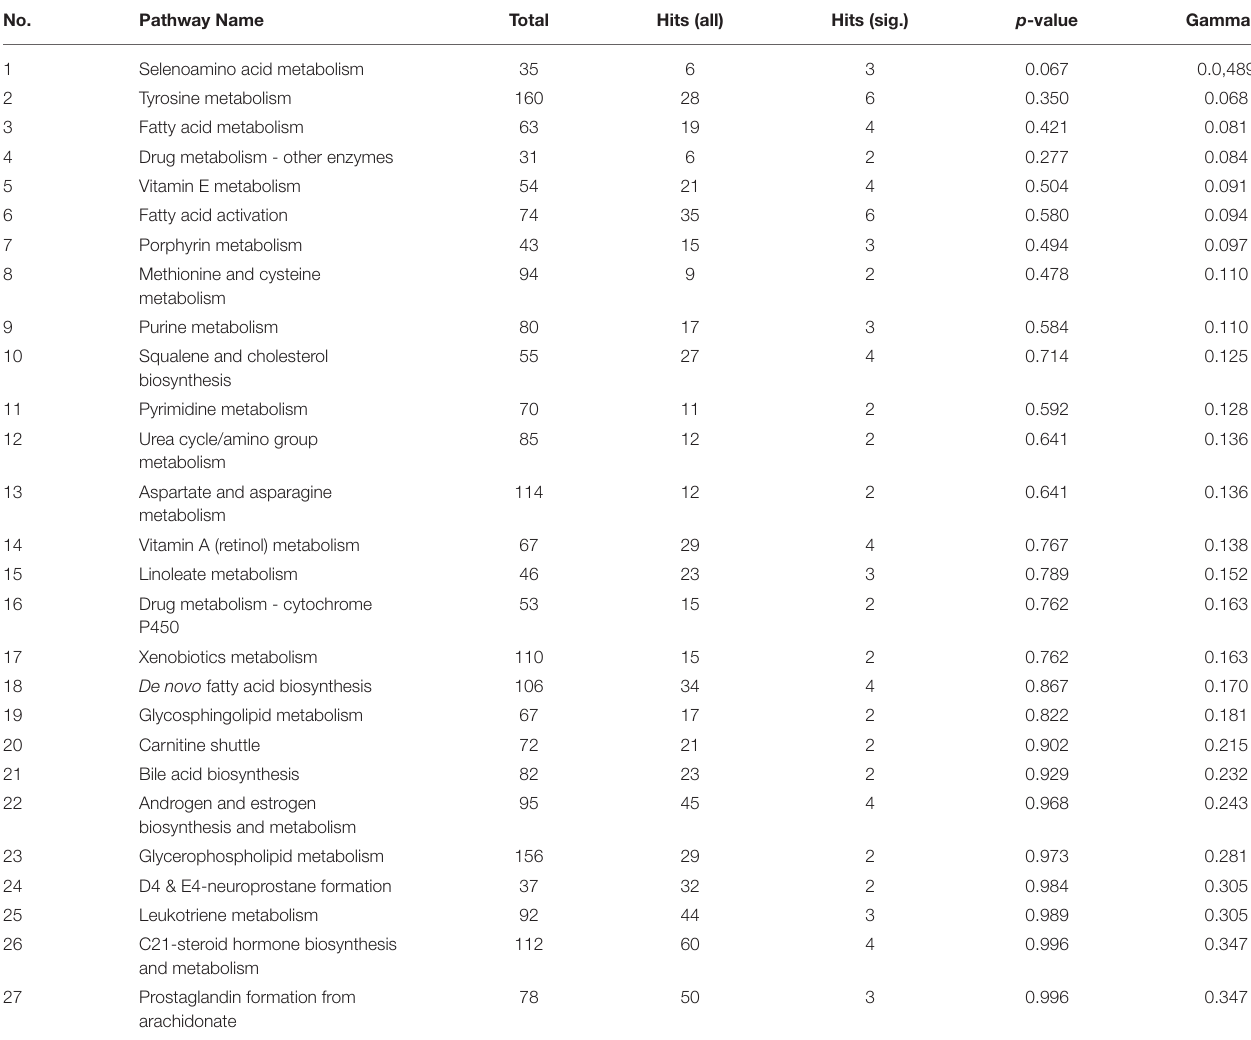
TABLE 3 | List of metabolic pathways identified in dog saliva after 30 days of Ascophyllum nodosum administration.